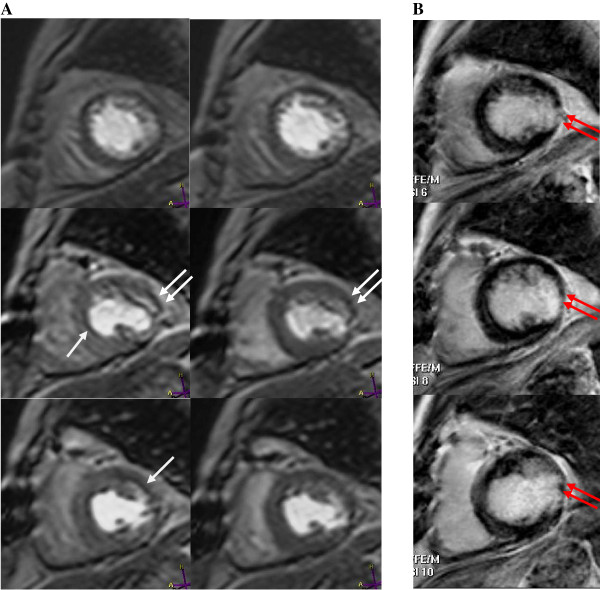
Myocardial first pass perfusion imaging. A, Apical (top row), mid (middle row) and basal (bottom row) short axis slices acquired at stress (left) and rest (right). Inducible ischemia demonstrated by myocardial hypoenhancement, which is visible at stress (single arrow) and absent at rest. Fixed perfusion defects present at stress and rest (white double arrows) corresponding to areas of infarction on B, Late gadolinium enhancement images. Basal to mid lateral infarction (red double arrows).